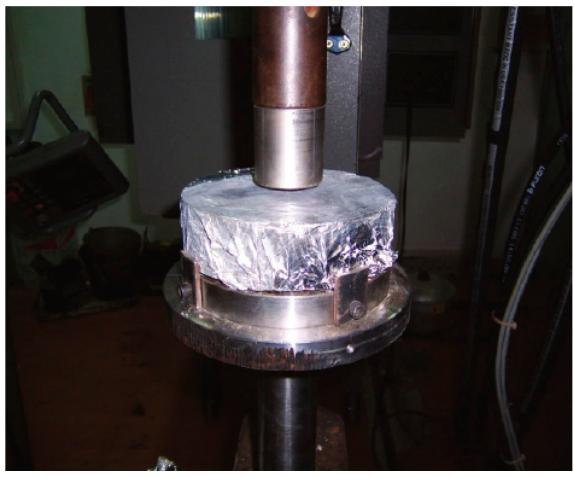
Figure 5. Circle shear test.